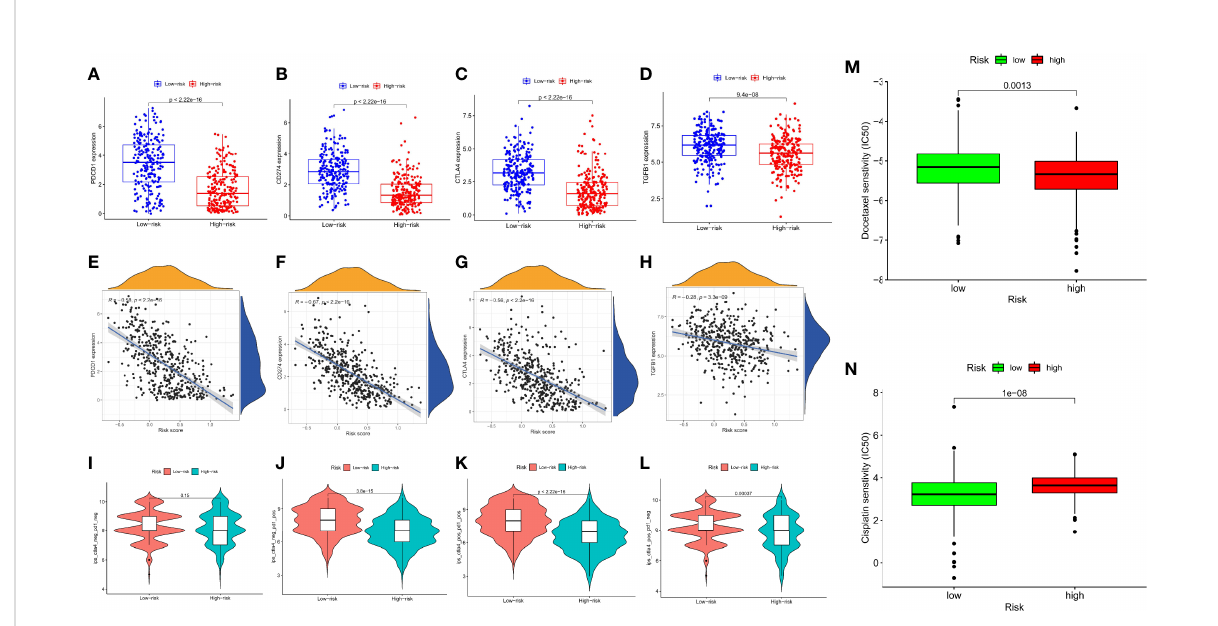
FIGURE 8 Relationship Between the Prognosis-Associated Immune Signature and Drug Response in SKCM. The differential expression of (A) PDCD1, (B) CD274, (C) CTLA4, (D) TGFB1 in the two subgroups, correspondingly; Spearman correlation analysis of risk score and (E) PDCD1, (F) CD274, (G) CTLA4, (H) TGFB1; (I) IPS score distribution plot; (J) IPS-PD1 blocker score distribution plot; (K) IPS-CTLA4/PD1 blocker score distribution plot; (L) IPS-CTLA4 blocker score distribution plot; (M) Boxplot comparing patient response to docetaxel chemotherapy; (N) Boxplot comparing patient response to cisplatin chemotherapy. (ns, not signi fi cant, *P < 0.05, **P < 0.01, and ***P <